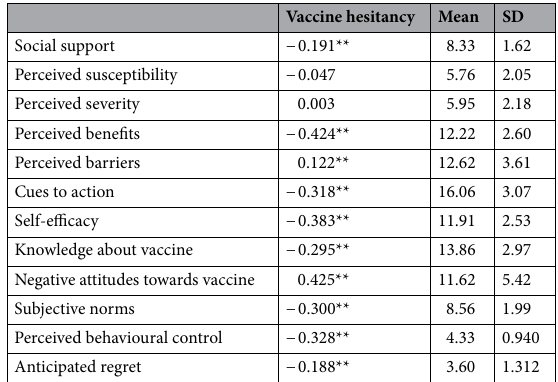
Table 4. Correlation matrix: domains of health belief model and domains of the theory of planned behaviour and vaccine hesitancy. ** p < 0.01.